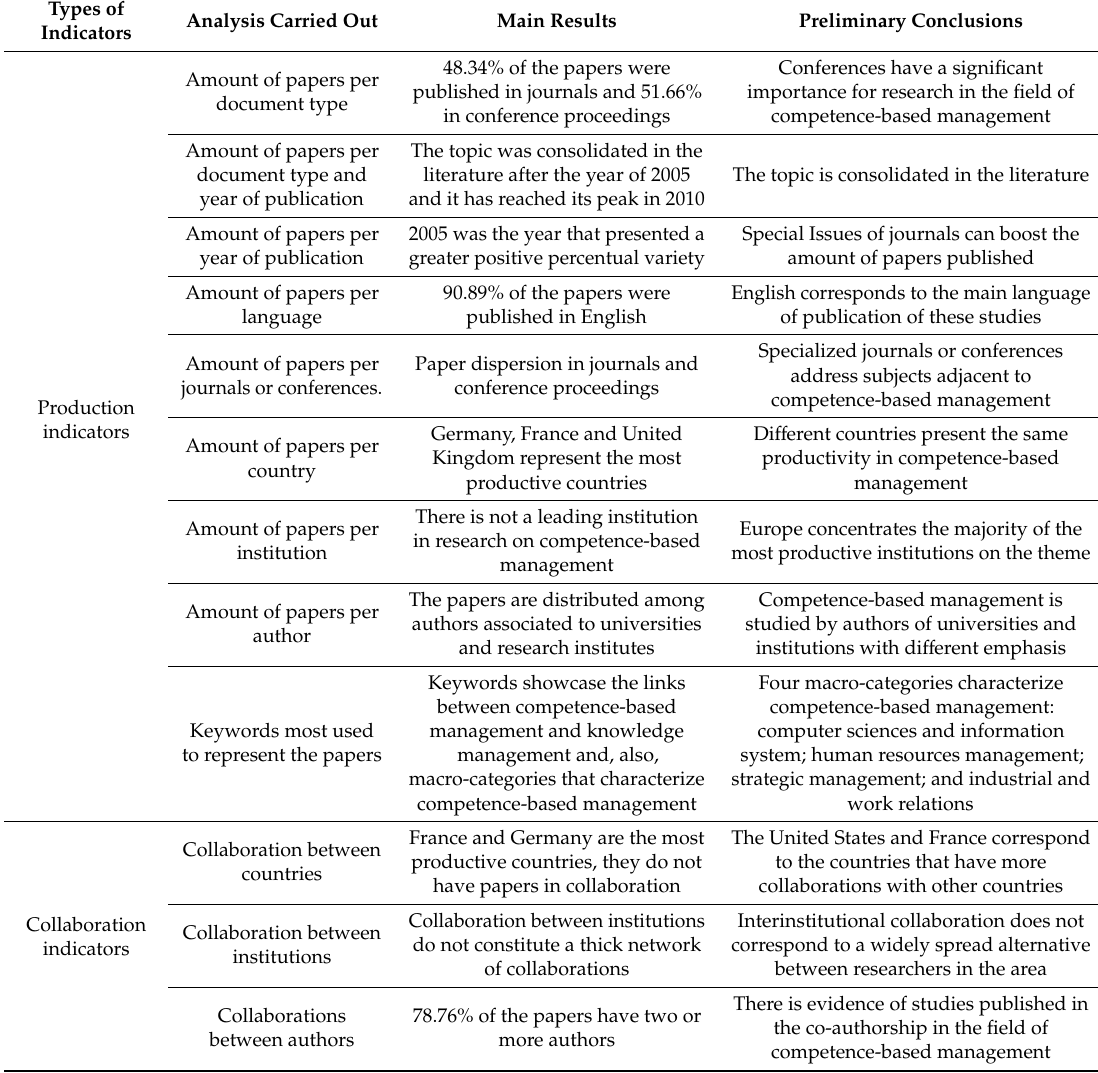
Table 15. Characteristics of the papers that address competence-based